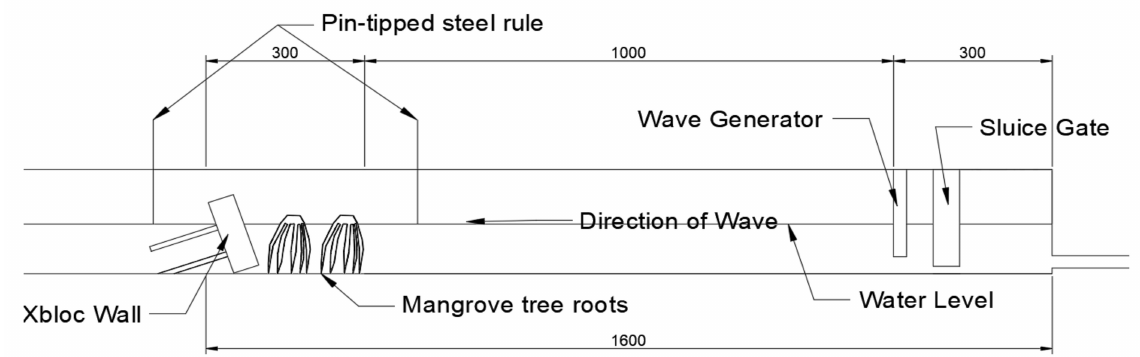
Figure 2. Sketch of experimental setup within the 5 m flume